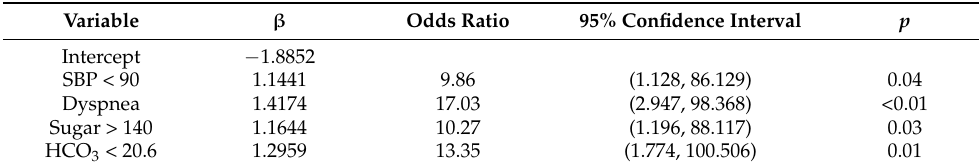
Table 5. Logistic model for predicting the probability of mortality of drug users.